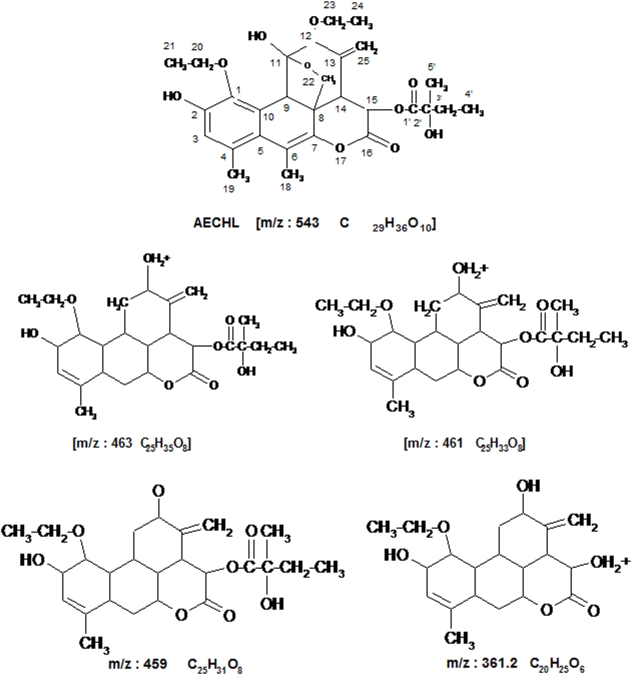
Structure of AECHL-1 with its mass fragments by NMR
spectroscopy.